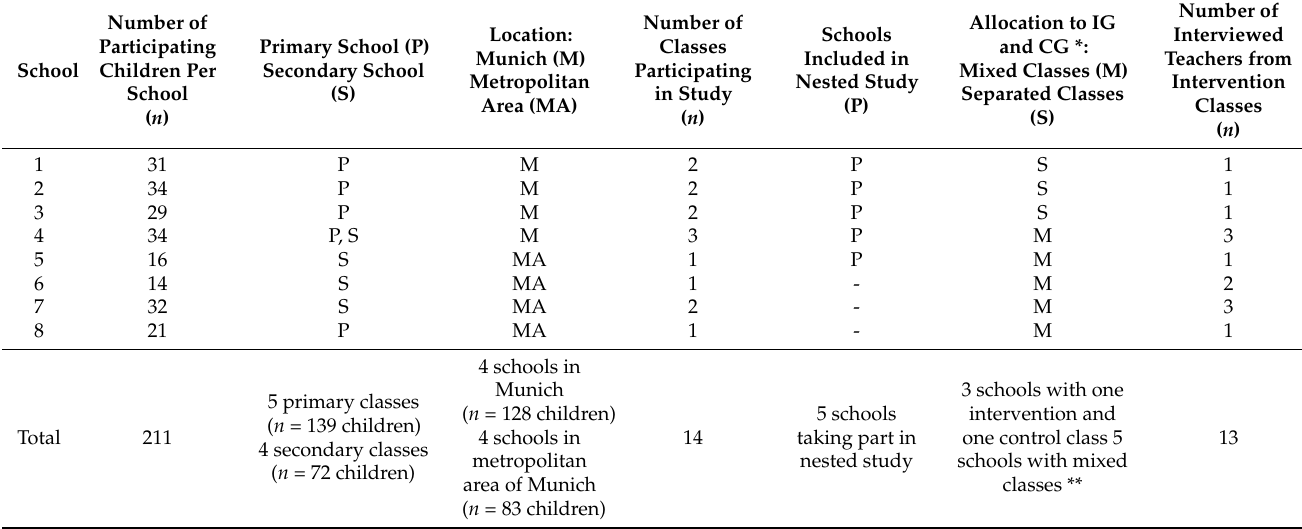
Table 1. School Table 1. School characteristics.